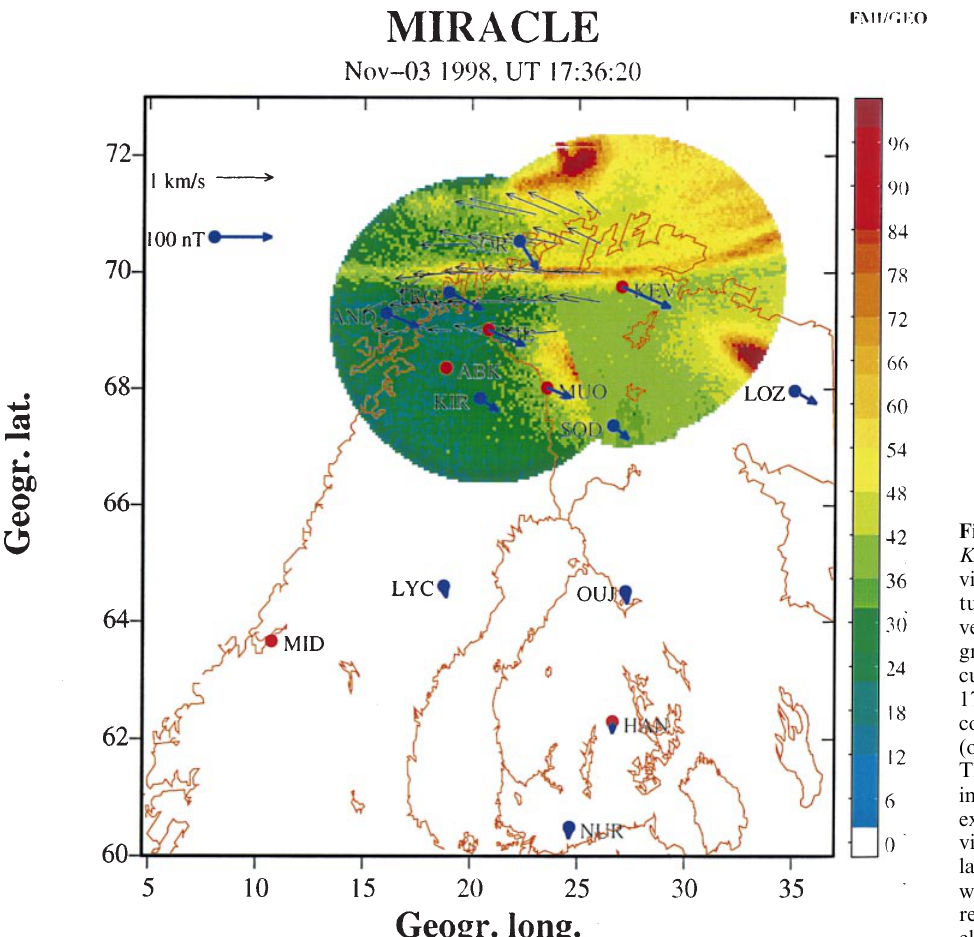
Fig. 5. MIRACLE plot showing KIL and KEV all-sky camera views mapped to 110 km alti- tude, STARE electron velocity vectors ( black ) and IMAGE ground magnetometer equivalent current vectors ( dark blue ) 17:36:20 UT. The color scaling corresponds to ASC pixel values (originally in the range 0–255). The red spots in the southeast are images of the Moon. Arc 2 extends through both camera views close to 70 (cid:14) geographic latitude. STARE shows a west- ward drift of about 1 km/s (cor- responding to a northward electric field of about 50 mV/m)